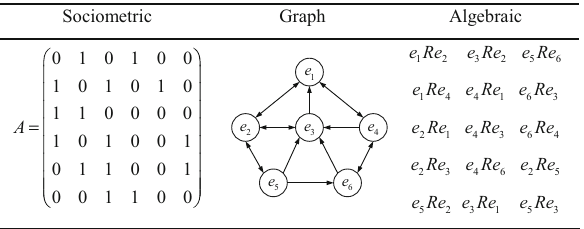
Table 1 Different representation schemes of SNA Sociometric Graph